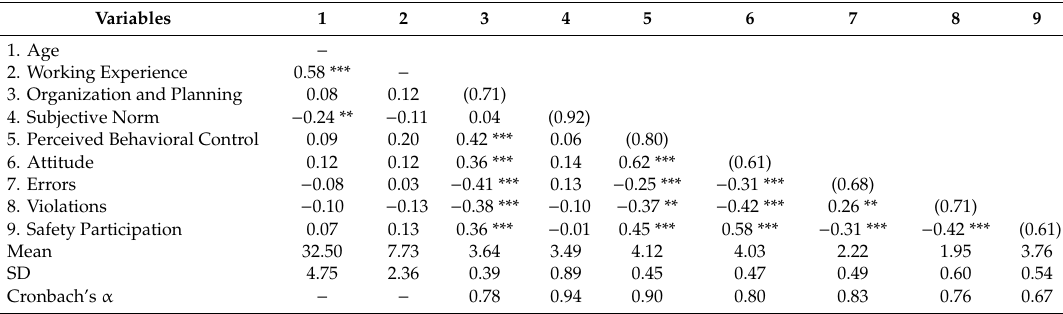
Table 2. Mean, standard deviation (SD), and zero-order correlation between